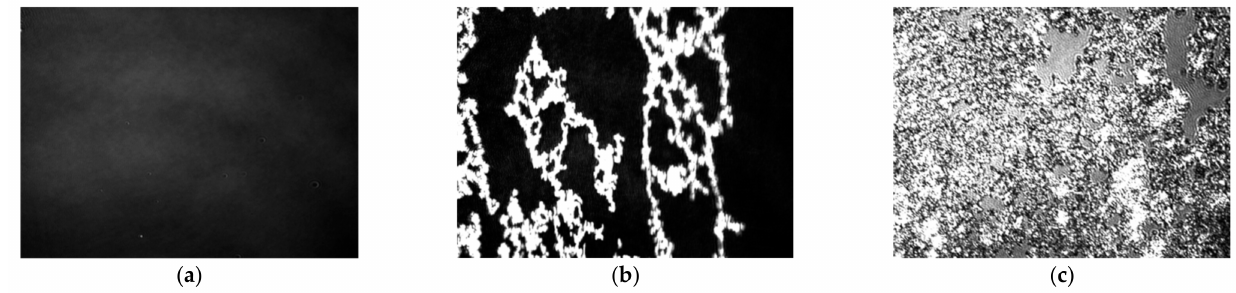
Figure 5. BAM images taken for kaempferol at three surface pressures: ( a ) 0.08 mN/m, ( b ) 30.13 mN/m, and ( c ) 54.47 mN/m.The images were captured during compression at constant temperature and surface pressure in the field of view 3.6 × 4.0 mm. A black glass plate immersed in the subphase absorbed the refracted beam. The resolution of image was approx. 6 µ